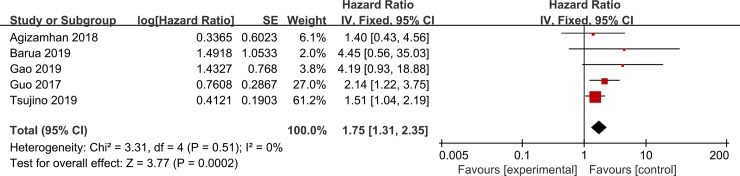
Forest plots of the correlation between CAR and DFS/PFS in RCC patients.